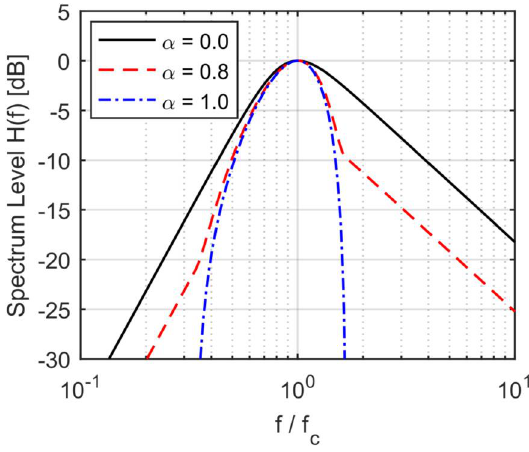
Figure 9. Examples of the shape of the spectrum for different values of α